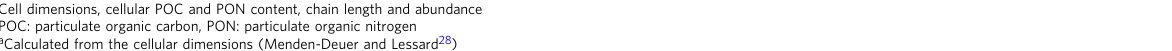
Cell dimensions, cellular POC and PON content, chain length and abundance POC: particulate organic carbon, PON: particulate organic nitrogen a Calculated from the cellular dimensions (Menden-Deuer and Lessard 28